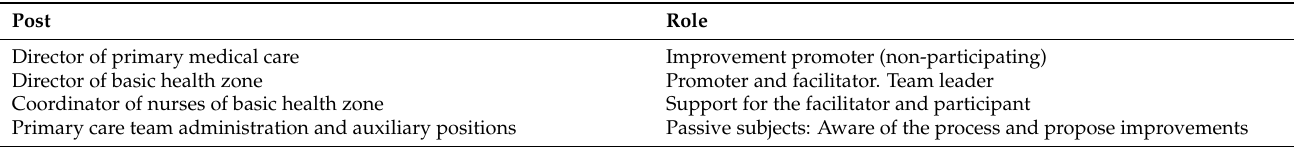
Table 2. Team and